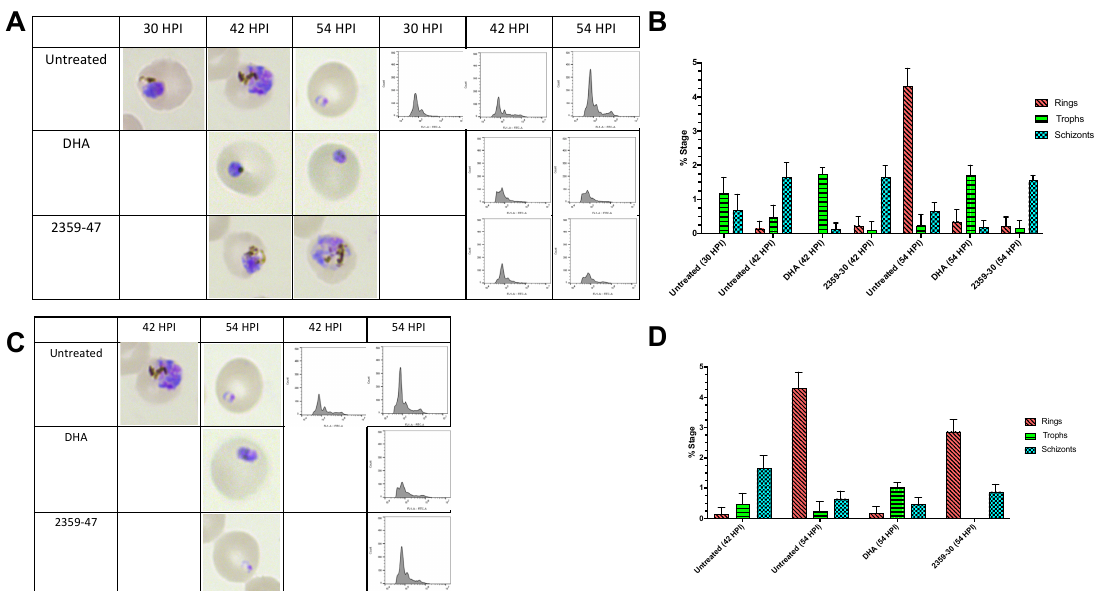
Figure 6. Stage-specific inhibition of Plasmodium growth by TPI 2359-47. ( A ) Microscopic evaluation of Giemsa-stained thin smears and flow cytometric analysis of the YOYO-1-labeled cells to measure DNA content when the culture was exposed to the inhibitor (5 × EC 50 ) at 30 h postinvasion. ( B ) Distribution of different stages when the culture was treated at 30 h postinvasion. ( C , D ) Effect following exposure of the parasite to the compound at 42 h postinvasion. Three replicates of 1000 parasitized erythrocytes were counted to determine stage-specific distribution. DHA, dihydroartemisinin.